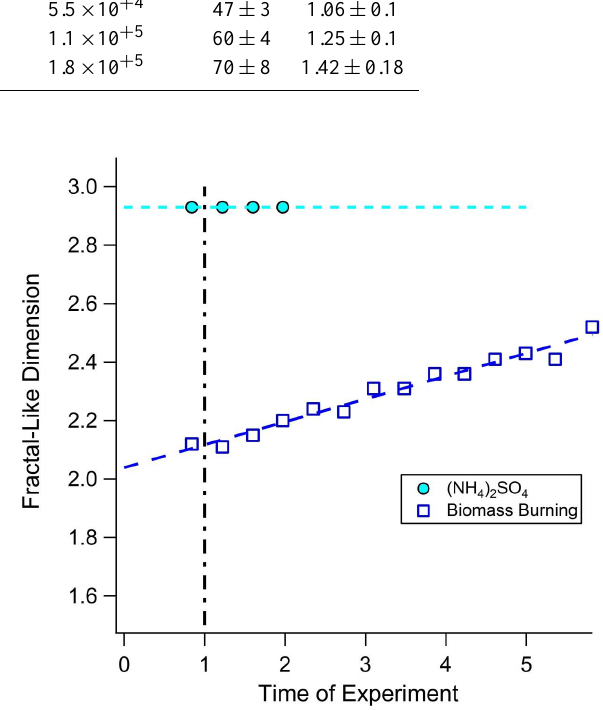
Figure 5. APM-SMPS derived fractal-like dimension data vs. time of experiment. A 782 Figure 5. APM–SMPS derived fractal-like dimension data vs. time fractal-like dimension of 3 indicates a spherical particle while D f < 3 is non-spherical. Black line 783 of experiment. A fractal-like dimension of 3 indicates a spherical indicates time of UV lights being turned on. Ammonium sulfate calibration data is included for 784 particle, while D f <3 is nonspherical. Black line indicates time of comparison. 785 UV lights being turned on. Ammonium sulfate calibration data is included for